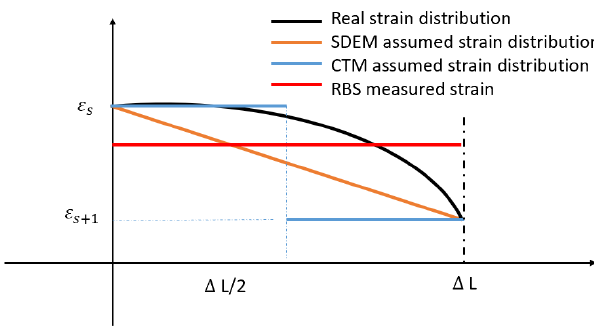
Figure 7. Strain distribution within different algorithms.